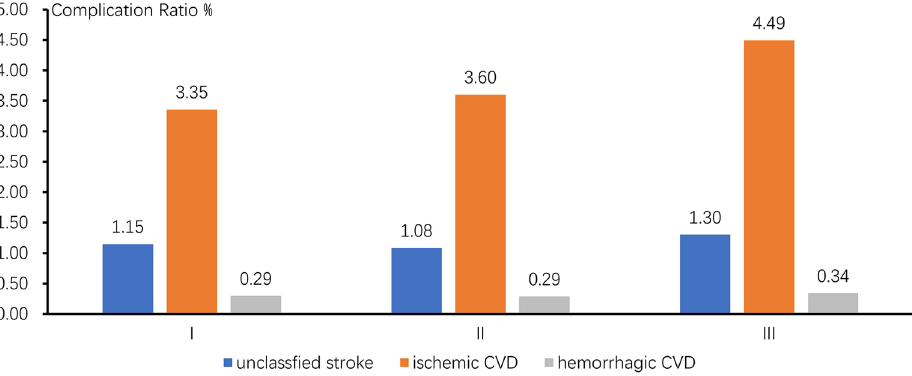
Figure 3. Complication ratio of CVD in different blood pressure grad.